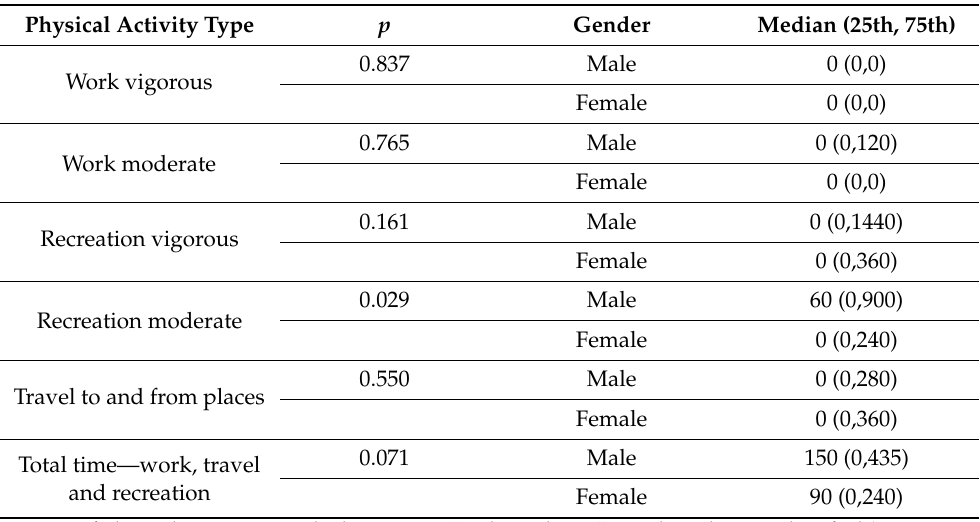
Table 3. Level of activity by gender (METs per